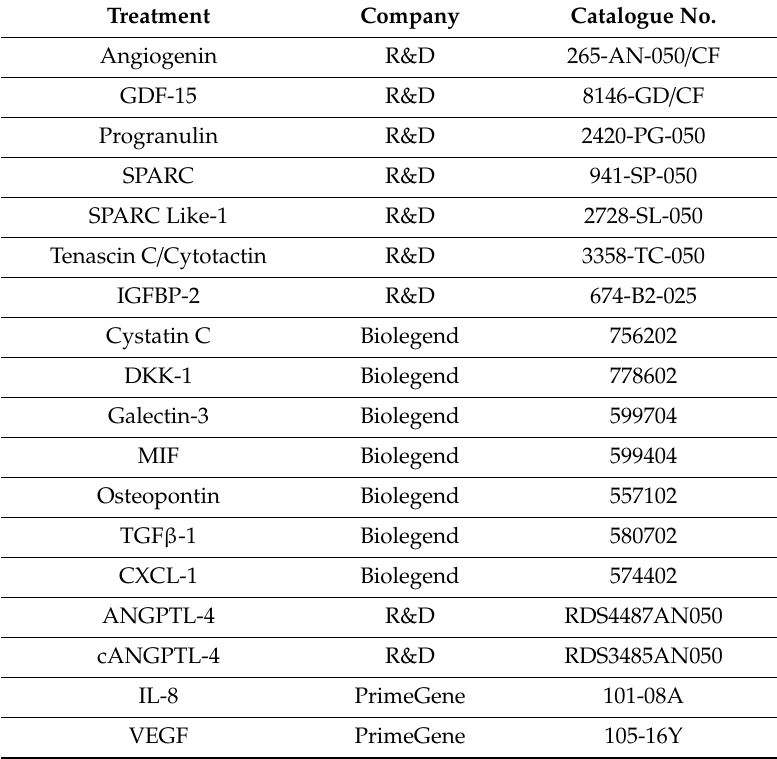
Table A3. Recombinant cytokines and supplier